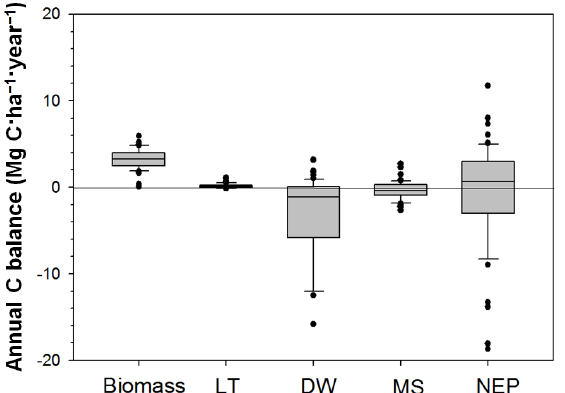
Figure 1. Annual carbon (C) stock changes in biomass, litter (LT), dead wood (DW), and mineral soil (MS), and net ecosystem production (NEP).